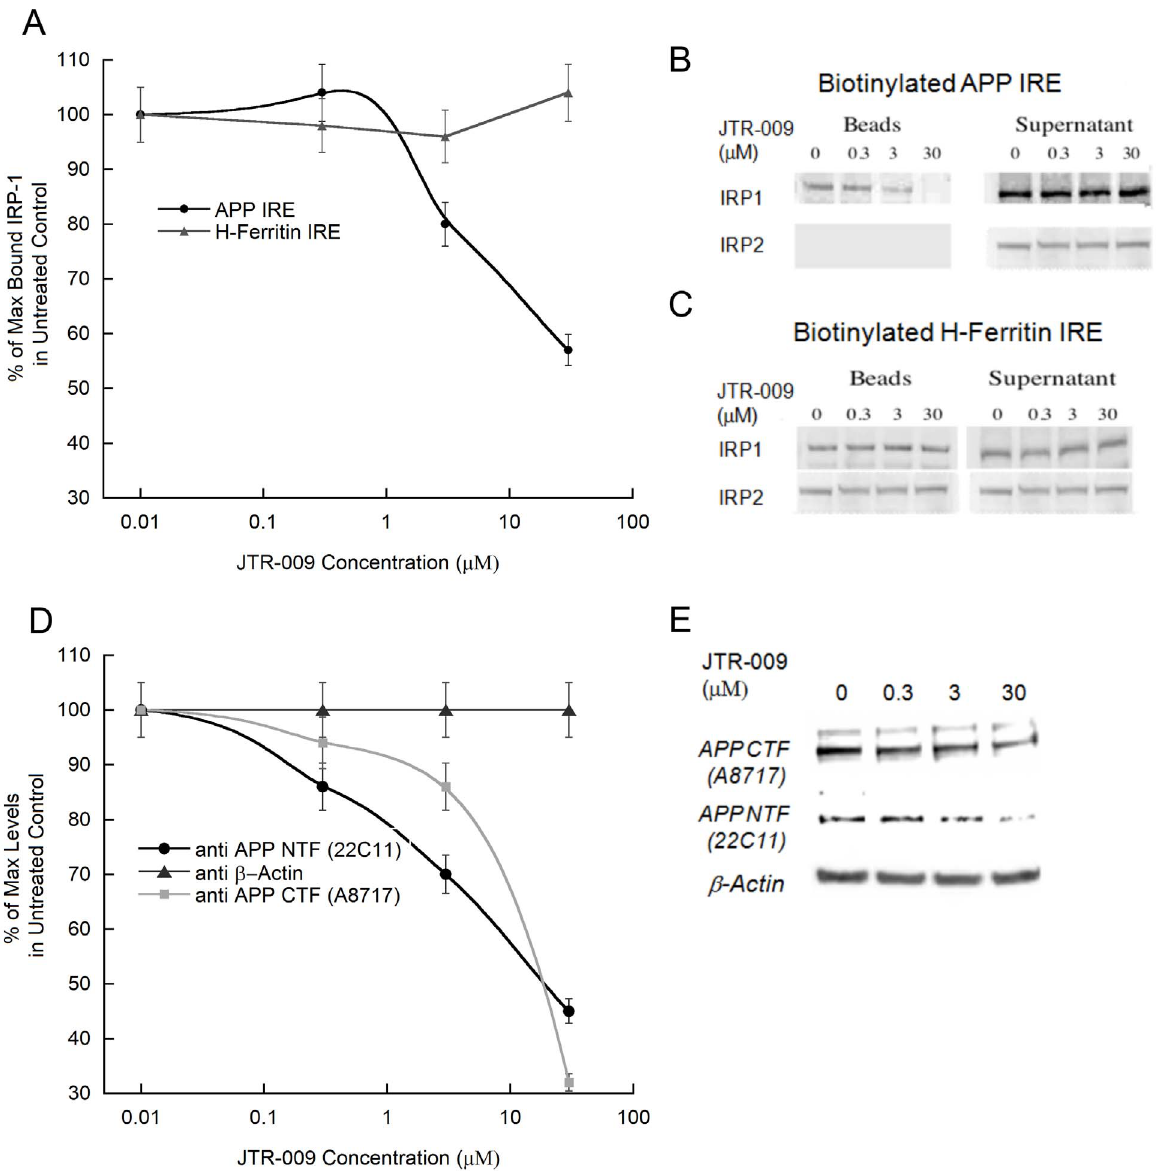
Figure 5. RNA pulldown assay to measure the dose-dependent capacity of the cyclic benzimidazole JTR-009 to substitute for IRP1 binding to APP 5 9 UTR sequences in SH-SY5Y cells: correlated repression of APP translation. RNA pulldown assays were conducted as ilustrated in Figure 6 and as described by Cho et al., 2010 [6] Panel A and B : Representative RNA binding assays in which recovered beads measured the dose-responsive capacity of JTR-009 (0 m M 0.3 m M, 3 m M and 30 m M) to inhibit IRP1 binding to 30 base biotinylated probes encoding the APP 5 9 UTR. In Panel B Western blots measured relative levels of IRP1 and IRP2 bound to biotinylated RNA probes for APP IRE sequences after recovery in steptavidin bead fractions. Densitomteric quantitation of bead-specific IRP1 is shown in Panel A. Panel C : Measurement of the dose-dependent off- target action of JTR-009 to suppress H-ferritin IRE binding to SH-SY5Y specific IRP1 and IRP2 (bead fraction). Panel D and E : Dose-dependent decrease of APP levels in response to JTR-009 measured in the supernatants of bead fractions (experimental , control set (p , 0.00 1). Panel E : Western blots of lysate supernatants showing APP as measured using the N terminal specific 22C11 and C-terminal specific A8717 anitibodies. Panel D : Densitometric quantitation of the data in Panel E to measure the extent to which JTR-009 dose dependently repressed APP expression in SH-SY5Y cells (Dunnetts test, p=0.03). Data from 5 separate trials, each in triplicate.